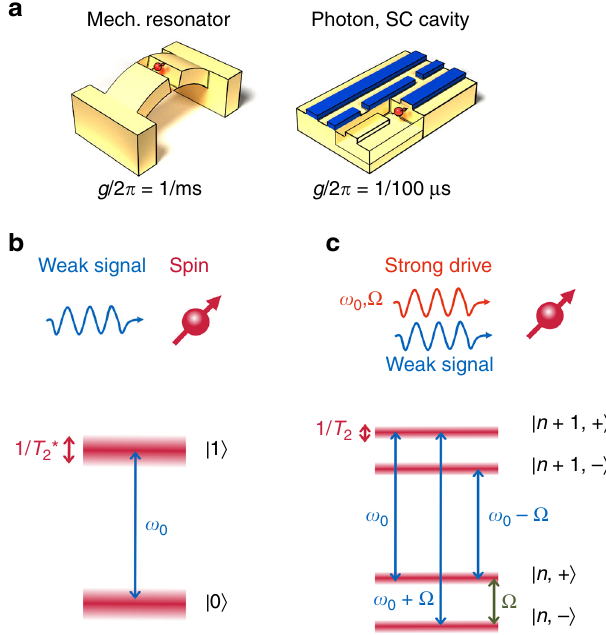
Fig. 1 High-frequency sensing by Mollow resonance